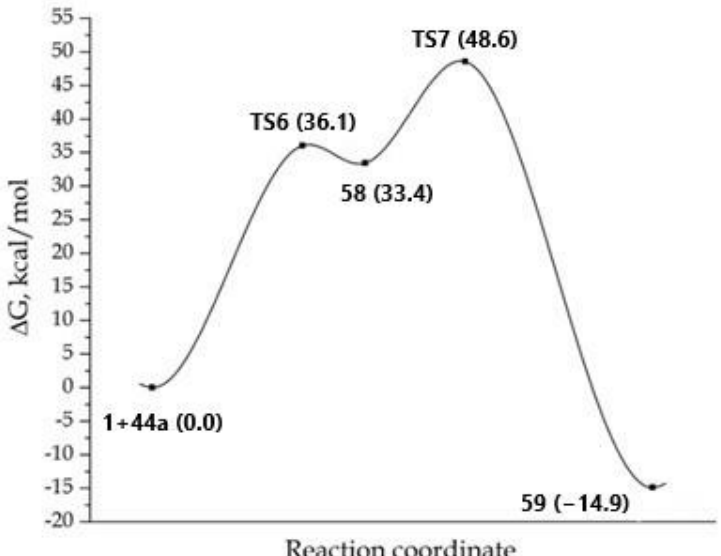
Figure 5. MEP for the reaction concerning the formation of adduct 59 . The total energy of starting reagents 1 and 44а was taken as the reference point.